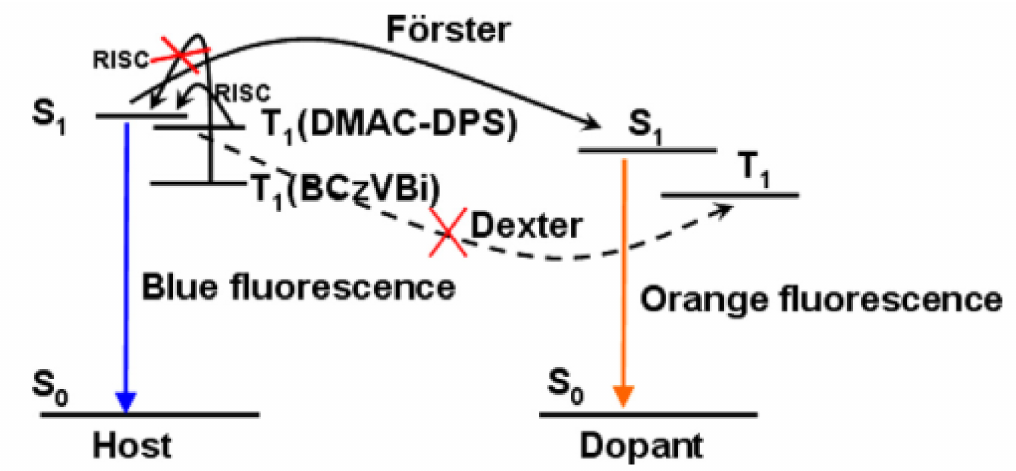
Figure 6. The energy transfer and electroluminescent emission processes in the single-EML WOLEDs based on TADF host materials. Reproduced with permission from [136], Elsevier,